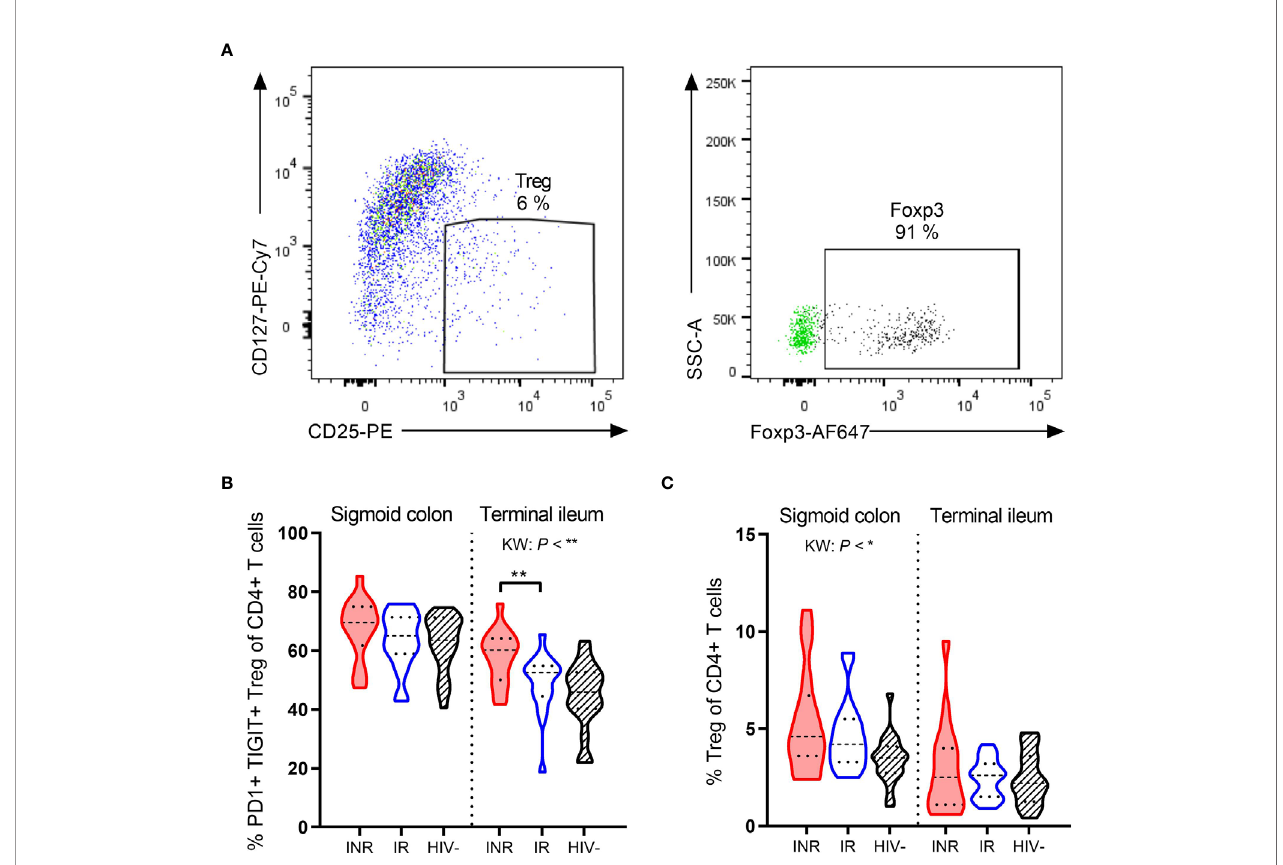
FIGURE 4 | INR have higher fractions of PD1 + TIGIT + Treg in terminal ileum. (A) Representative fl ow cytometry plot of regulatory T cells (Treg) from lamina propria mononuclear cells. In the right plot, fl uorescence-minus-one control for Foxp3 (green dots) is overlaid the fully stained sample (black dots). (B, C) Comparison of the PD1 + TIGIT + Treg (B) and percentages of Treg (C) and in sigmoid colon and terminal ileum in INR, IR and HIV negatives. INR indicated as red violin plots, IR as open blue violin plots, HIV negatives as lined black violin plots (dashed lines: median, dotted lines: quartiles). Statistical analyses were performed by Kruskal Wallis (KW) test with Dunn ’ s post-test between INR and IR. * P < 0.05, ** P <